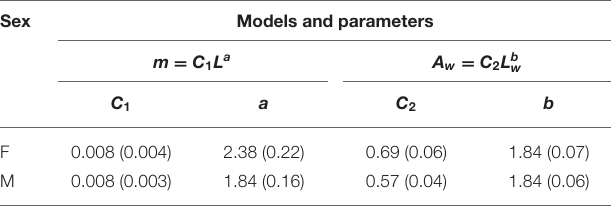
Values represent means with 1s.e. in brackets. Units are consistent with those in text and figures: L, cm; m, g; L w , cm; A w , cm 2